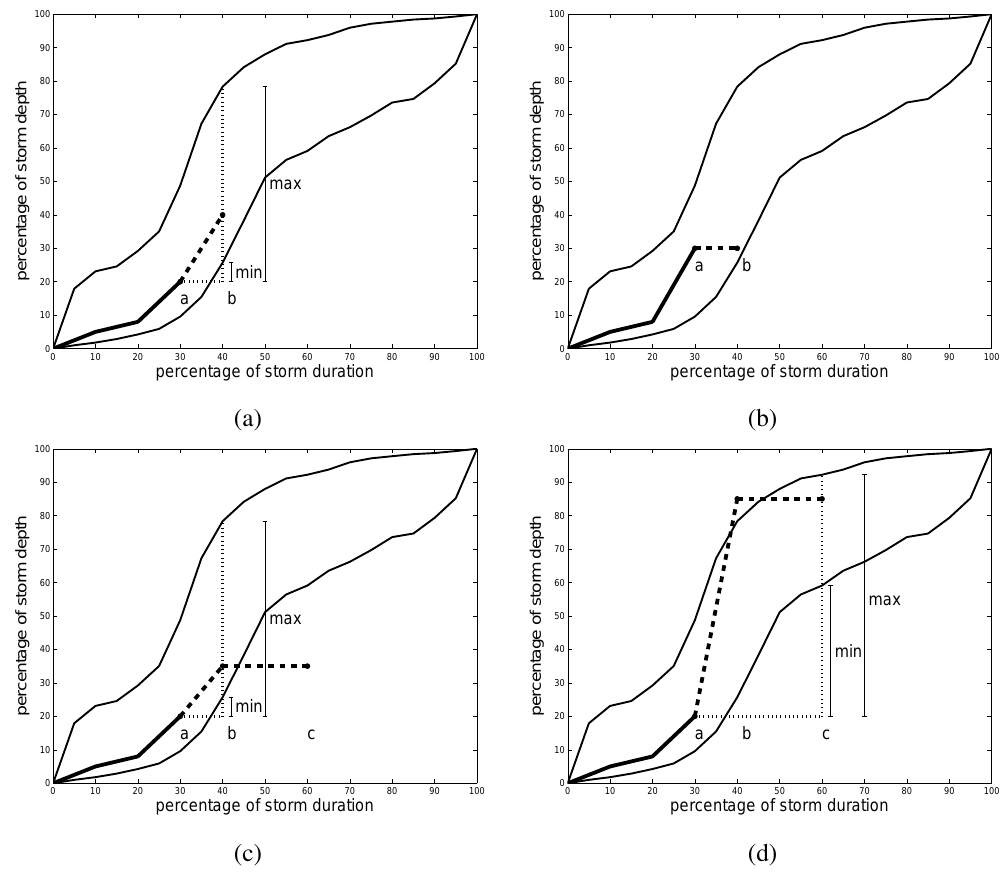
Figure 6. Illustration of the generation of an internal storm structure. The part of the Huff curve that is already generated (up to time instant a) is indicated by a thick solid line. The value at time instant b needs to be determined. Four sampling strategies are possible: sampling in between two consecutive wet periods (case 1; a ), sampling at the end of a dry period (case 2; b ), sampling at the end of a wet period followed by a dry period with a selection on the basis of the current time instant (case 3; c ) and with a selection on the basis of the last time instant in the dry period (case 3; d